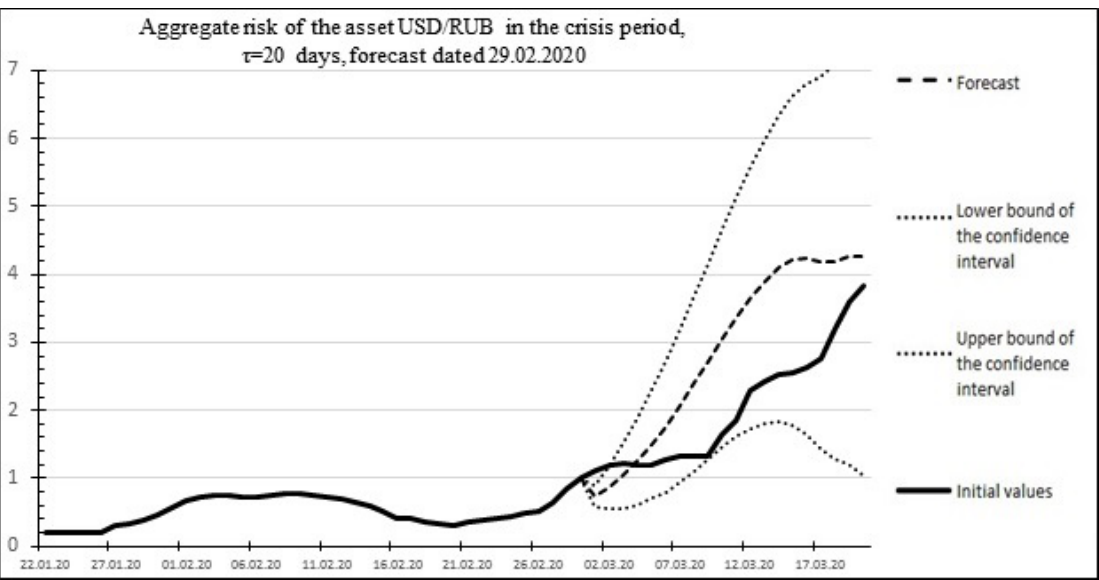
Figure 14. Final statistics of the initial data and results of the USD/RUB asset risk forecast during the crisis